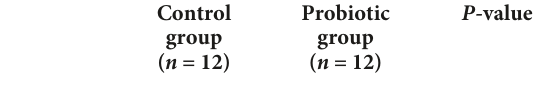
TABLE 1 Characteristics of